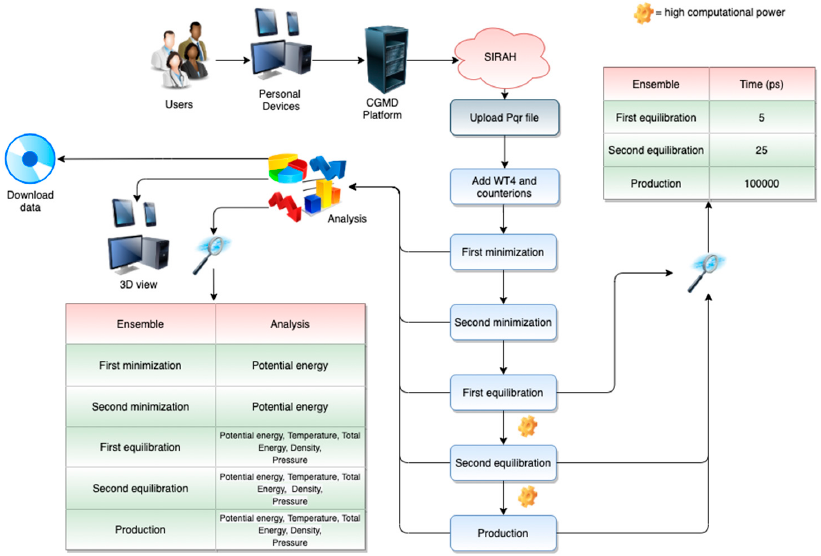
Figure 2. The SIRAH web server workflow.